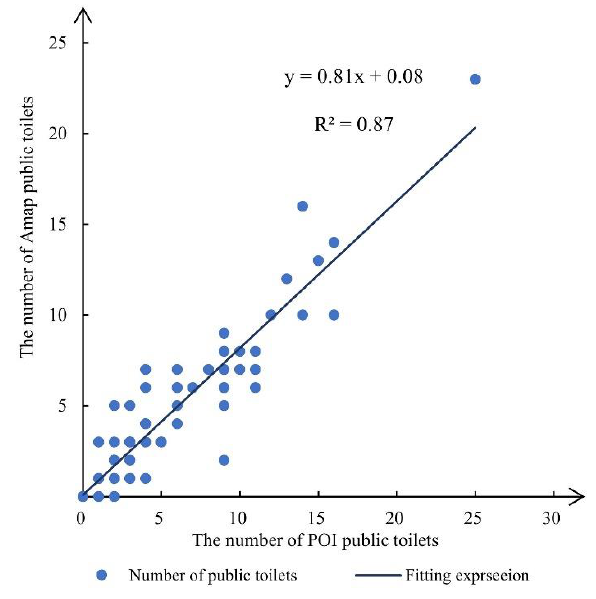
Figure 4. Fitting diagram of POI data and Amap data.